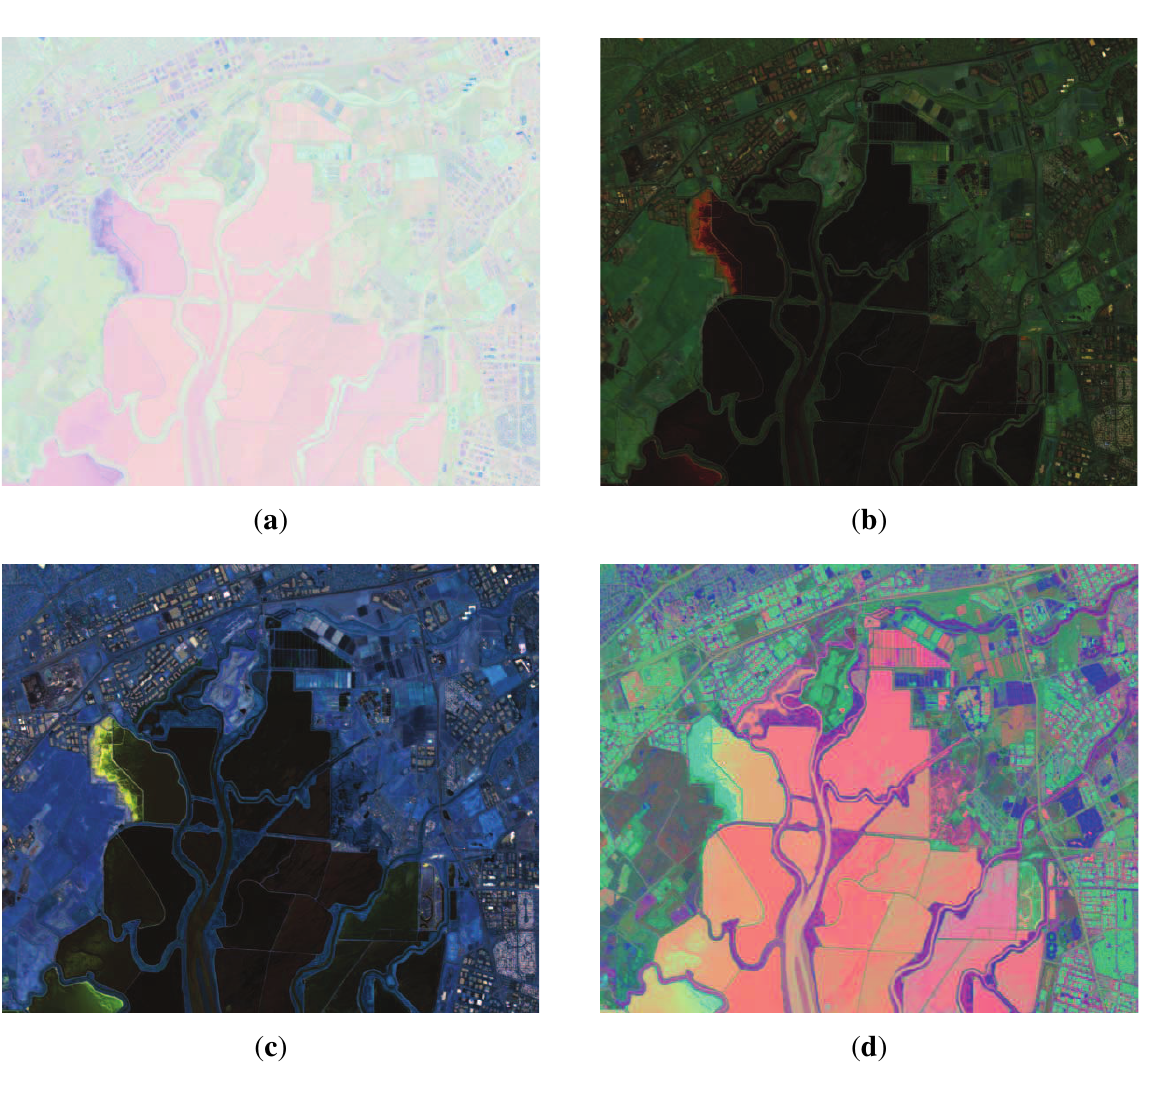
Figure 9. Visualization results for Moffett obtained by: ( a ) PCA; ( b ) BCOCDM; ( c ) PDADVS; and ( d ) PCA %2